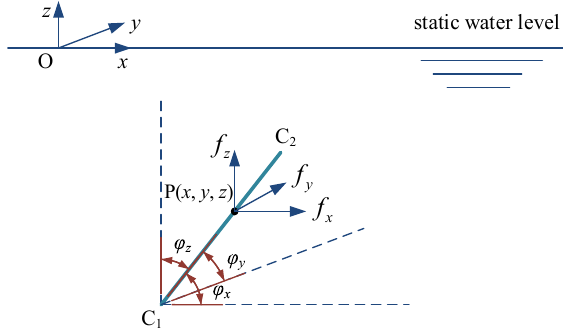
Figure 3. Distributed wave loads acting at point P( x , y , z ) on cylinder C 1 C 2 .